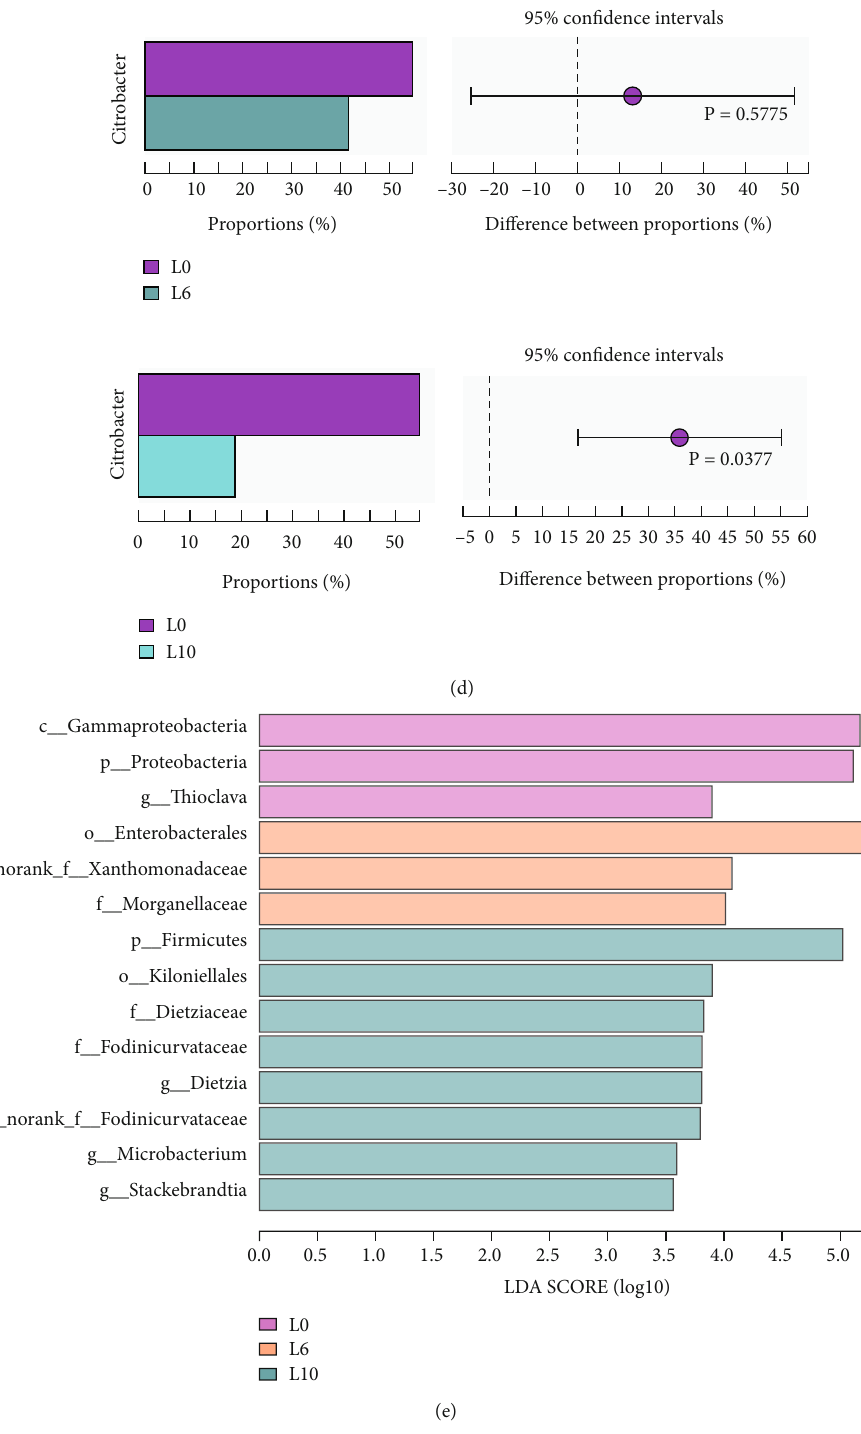
Figure 6: Di ff erences in bacterial community composition in C. quadricarinatus fed diets with di ff erent lipid levels. (a) The numbers of shared and unique OTUs. (b) The relative abundance of gut microbiota in C. quadricarinatus by phylum. (c) Comparisons of the relative abundance of the major bacteria in C. quadricarinatus at the phylum level. (d) The relative abundance ratio at the genus level. The middle shows the di ff erence between proportions of relative abundance in the 95% con fi dence interval, and P < 0 : 05 represents a signi fi cant di ff erence. (e) Bacterial taxa di ff erentially displayed in the gut of C. quadricarinatus raised were identi fi ed by LEfSe using an LDA score threshold of > 3.5. Data are expressed as the mean ± SE ( n = 4 ). Di ff erent letters indicate signi fi cant di ff erences among experimental groups ( P < 0 : 05